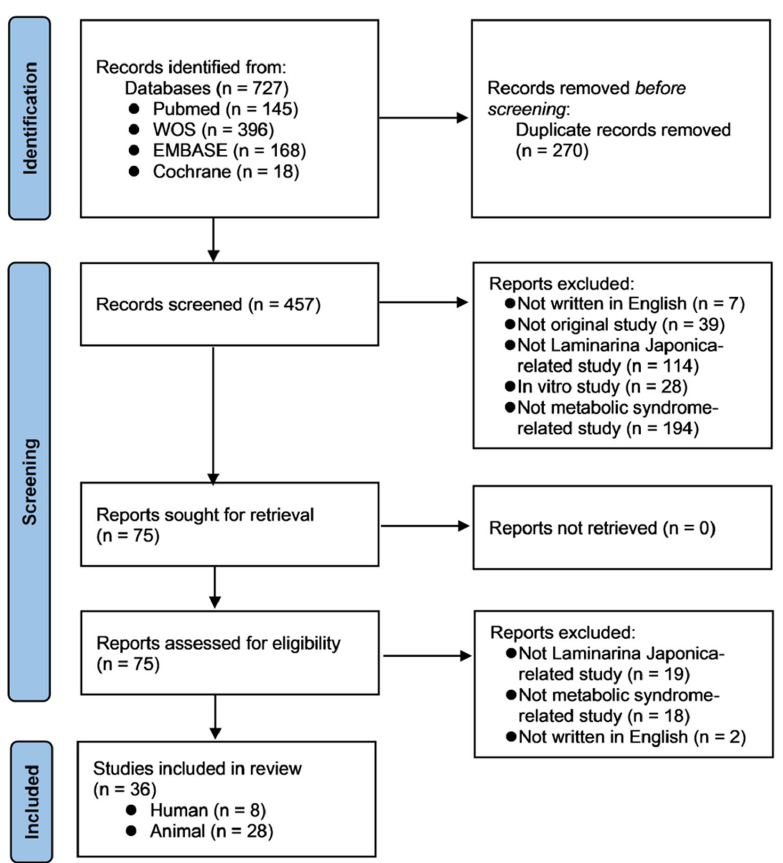
Figure 1. The PRISMA flow diagram of the selection and inclusion process of the studies .